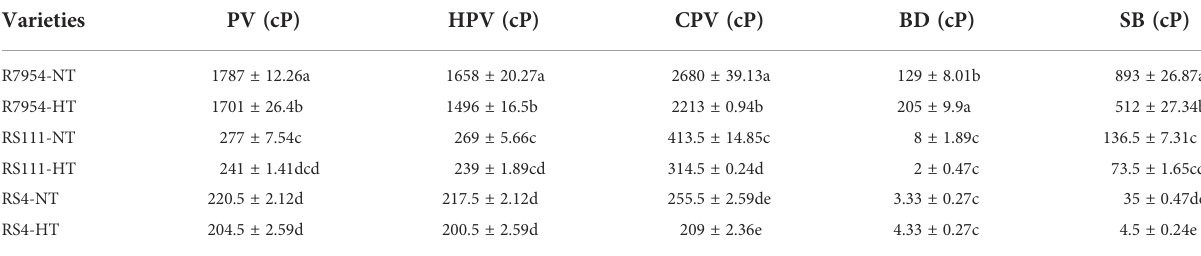
TABLE 5 Viscosity parameters of R7954, RS111, and RS4 under NT and HT*.